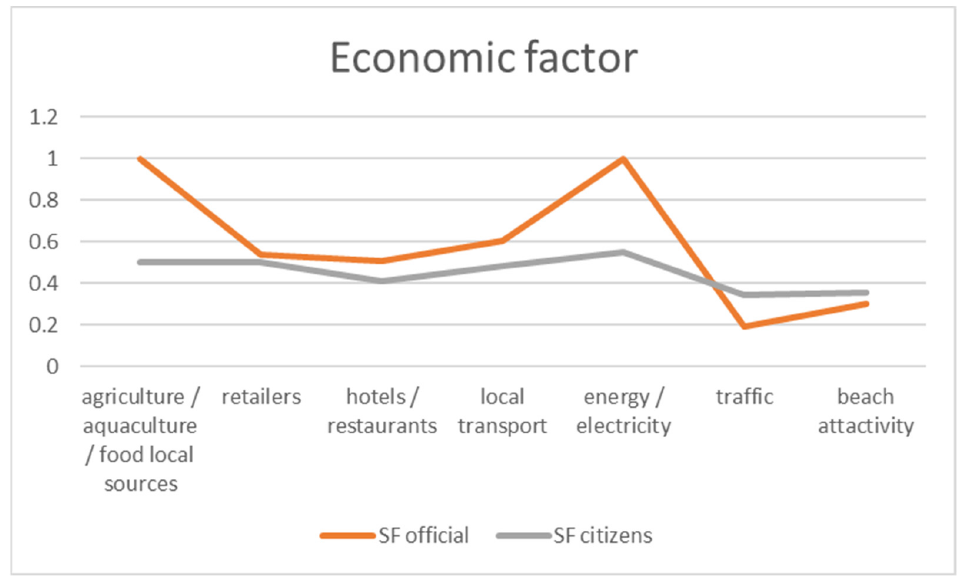
Figure 7. Analysis of economic activities by calculating the coefficient of the supportability factor.